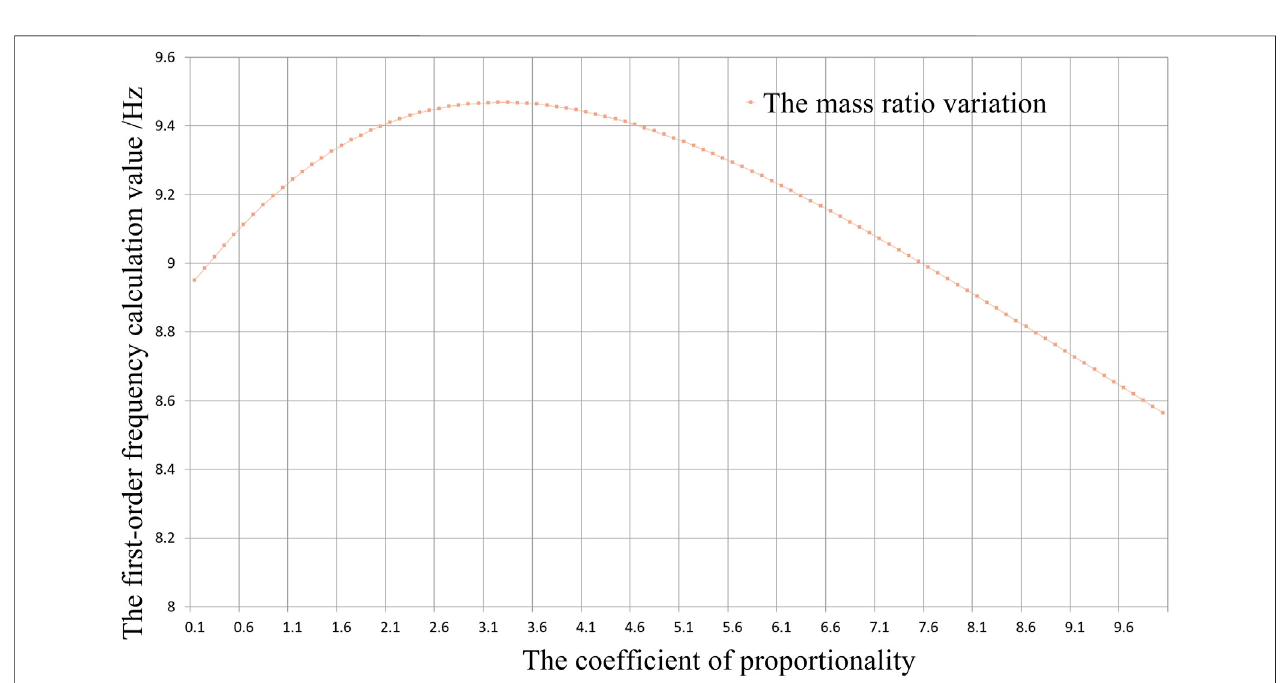
FIGURE 4 | The in fl uence of mass ratio variation of the self-tandem dual satellite on the fi rst-order fundamental frequency of the system.